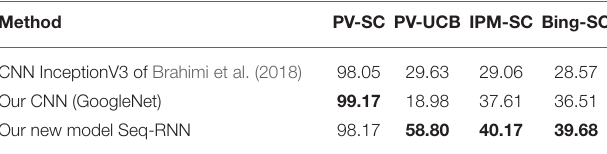
TABLE 1 | Top-1 accuracy (%) comparison on Plant Village (PV), IPM, and